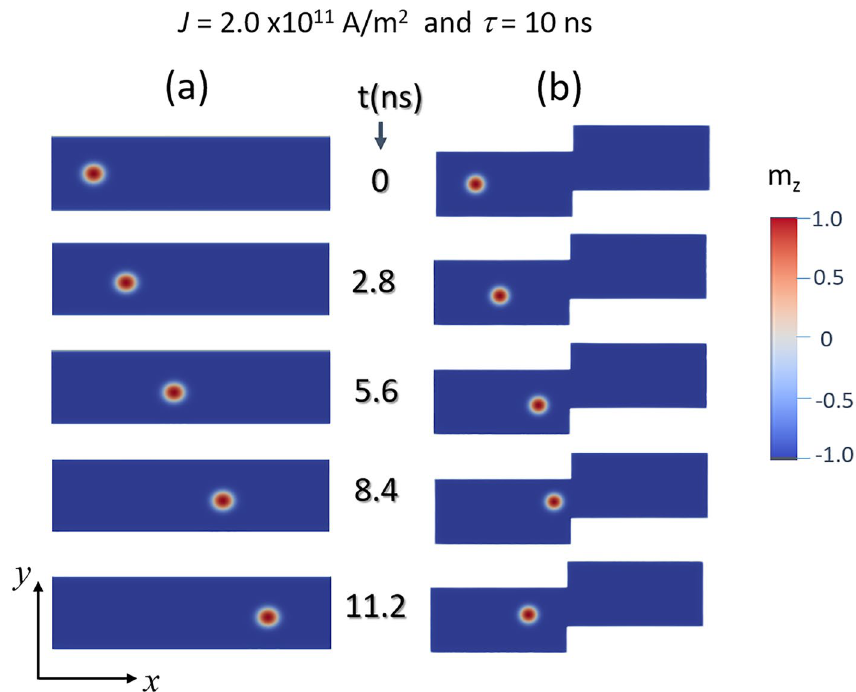
Figure 2. The time dependence of schematic of a skyrmion position for ( a ) conventional nanowire and ( b ) stepped nanowire. The colors represent the z -components of the spins. At the core of the skyrmion, the spin is pointing up and at the circumference, the spins are pointing down. The length of the device is L = 300 nm, the width W = 75 nm and thickness t z = 3 nm. The skyrmion is moving along the x -axis (from left to right).